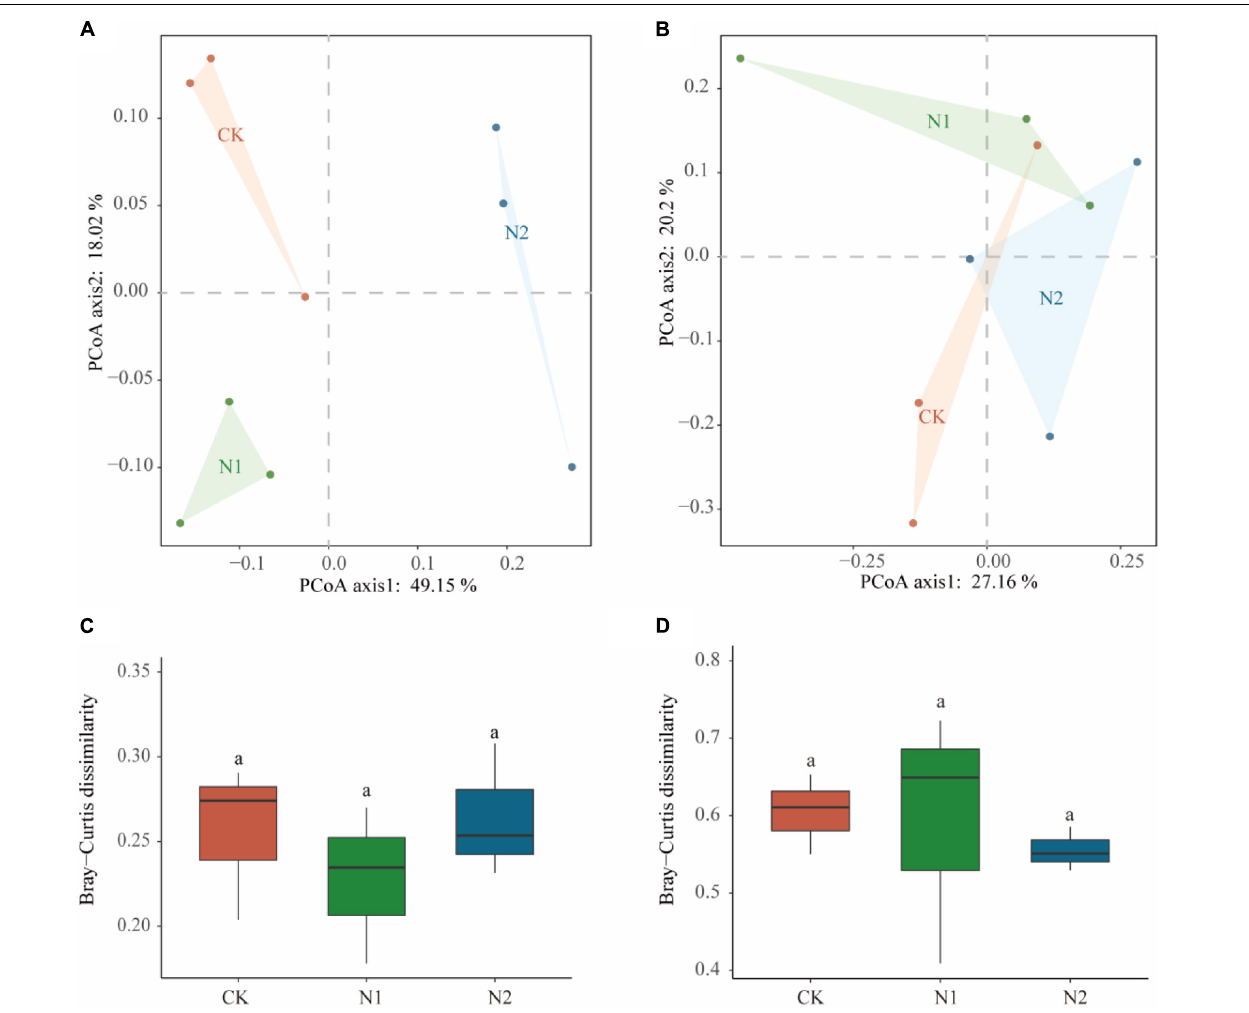
FIGURE 3 | Effects of N application on soil microbial community β -diversity. (A) Bacterial community PCoA based on Bray-Curtis dissimilarity. (B) Fungal community PCoA based on Bray-Curtis dissimilarity. (C) Bacterial community β -diversity differences. (D) Fungal community β -diversity differences.